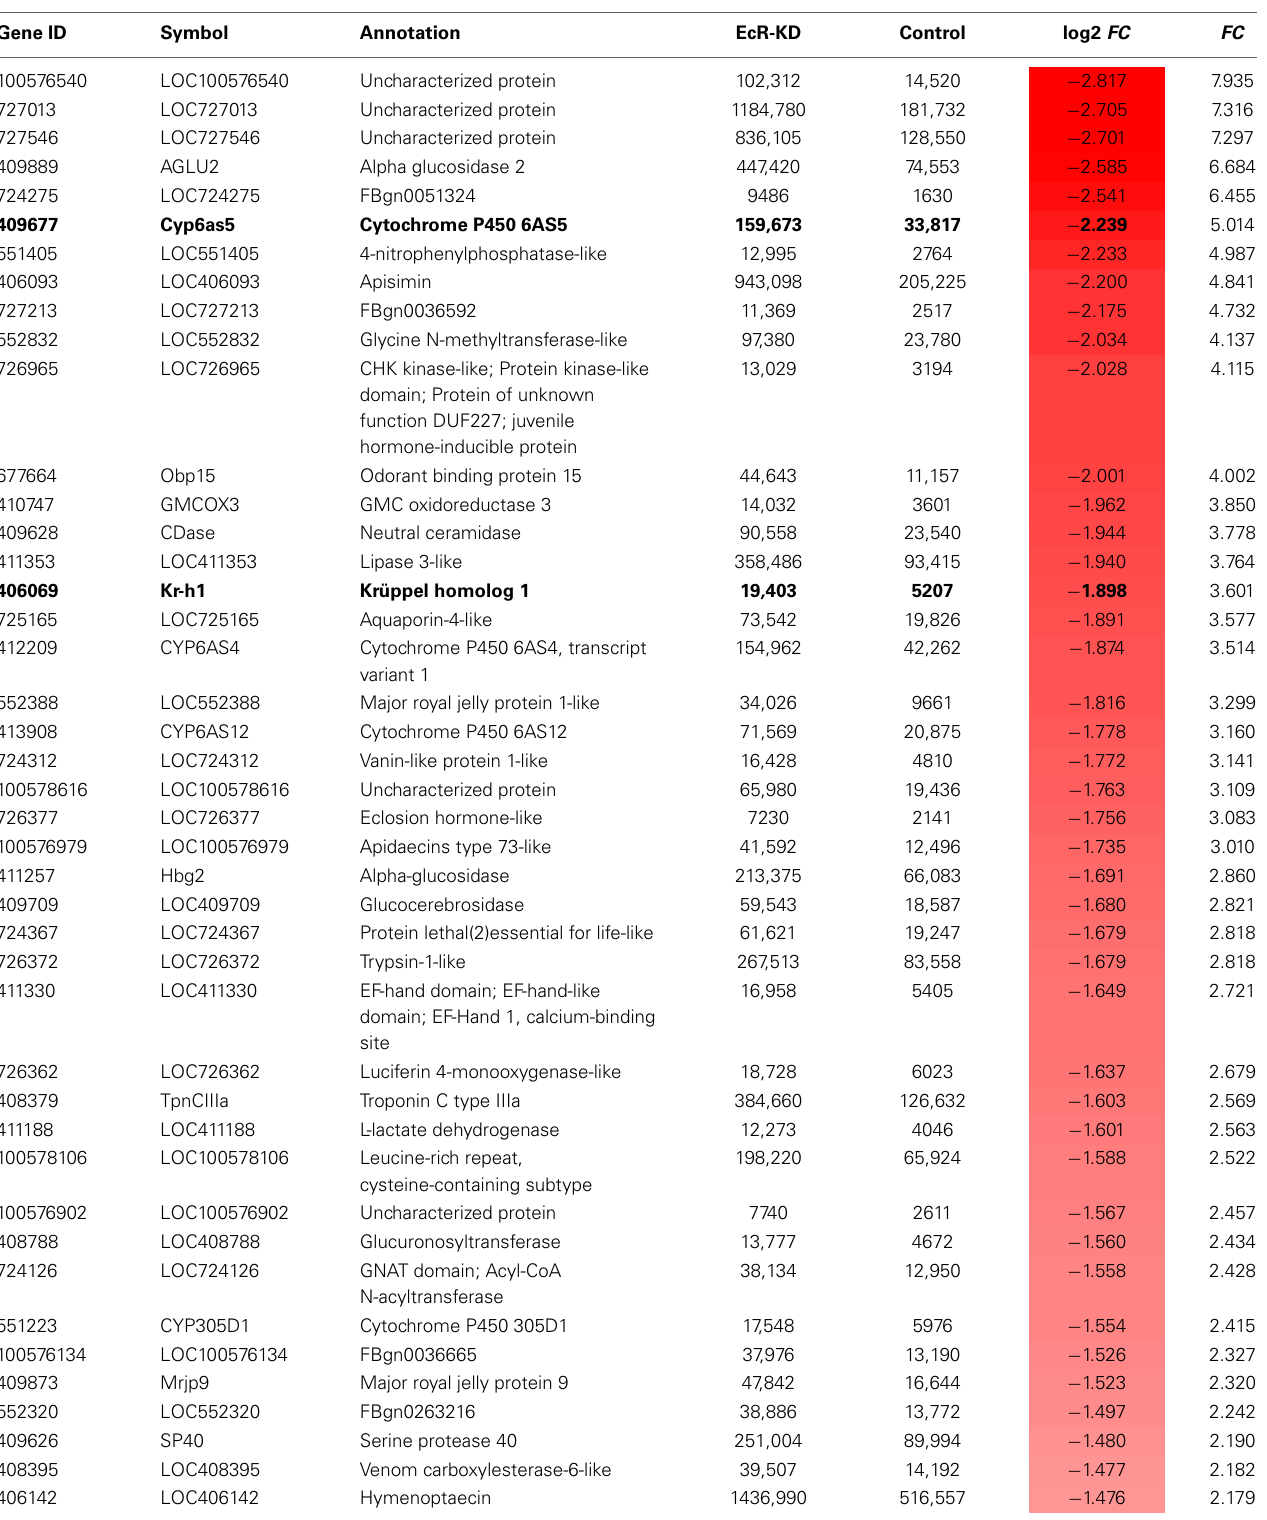
Table 2 | Protein-coding genes (121) that were differentially expressed in EcR knockdown (EcR-KD) bees ( FC ≥ 2; q -value ≤ 0.0015). Gene